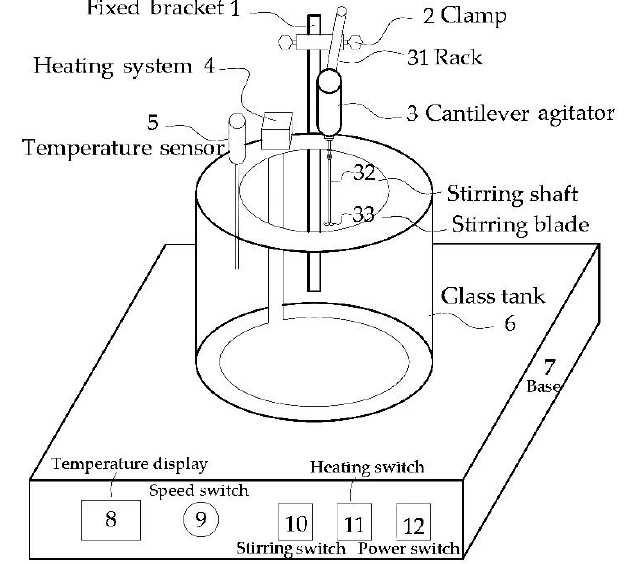
Figure 1. Glass thermostatic water bath.